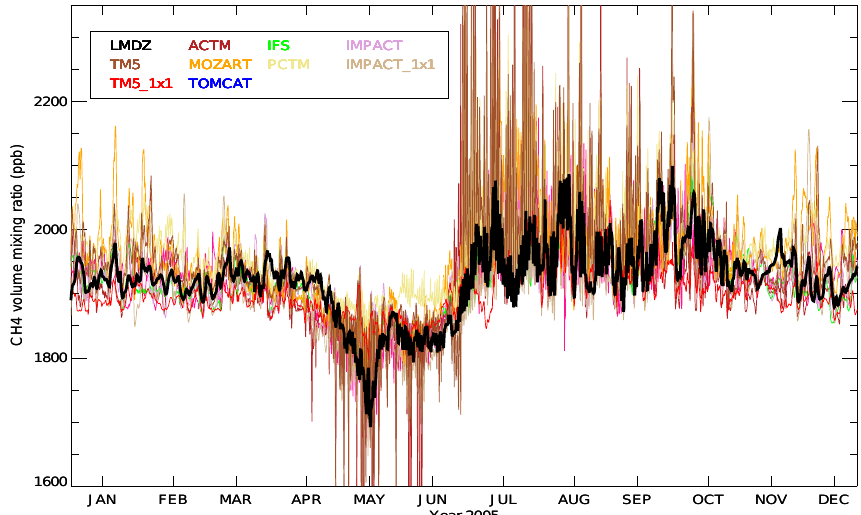
Fig. 3. Time series of daily CH 4 mixing ratio at Karasevoe (58.25 ◦ N, 82.40 ◦ E) for 2005. Each TransCom model is represented by a specific colour, while LMDZ-SACS is represented by the black line.